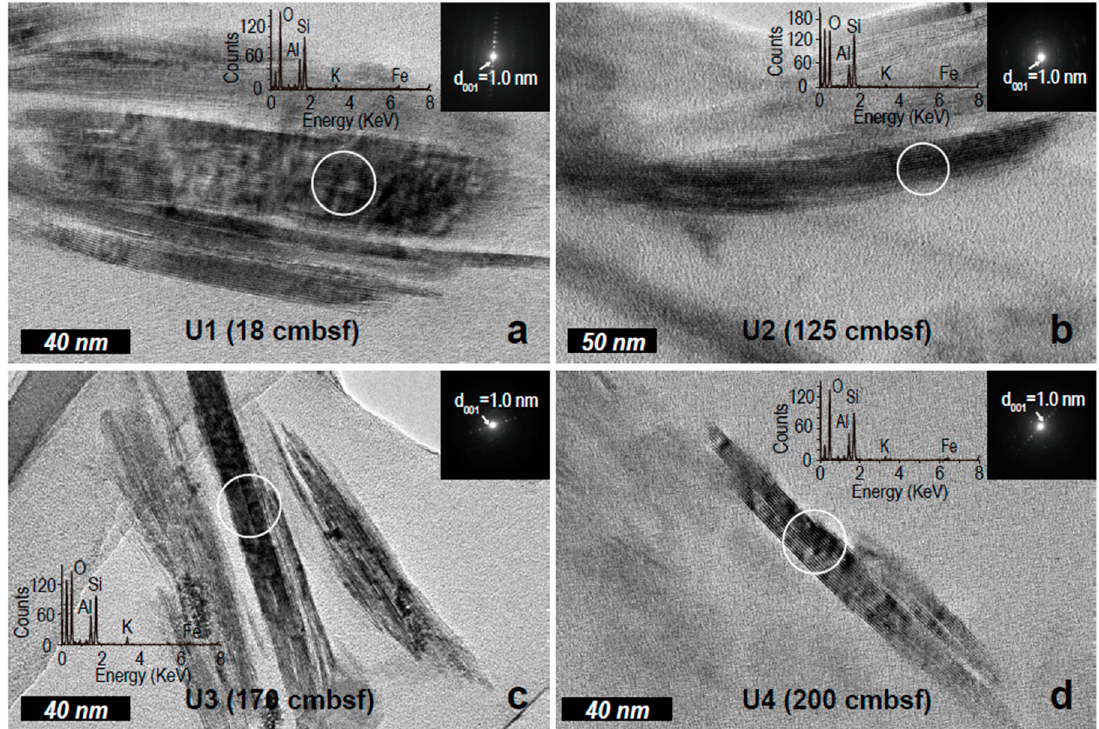
Figure 4. Representative transmission electron microscopy (TEM) lattice-fringe images and insets of corresponding selected area electron diffraction (SAED) patterns and energy-dispersive X-ray spectroscopy (EDS) from depths of ( a ) U1 (18 cmbsf), ( b ) U2 (125 cmbsf), ( c ) U3 (170 cmbsf), and ( d ) U4 (200 cmbsf) of the EAP13-GC17 core.